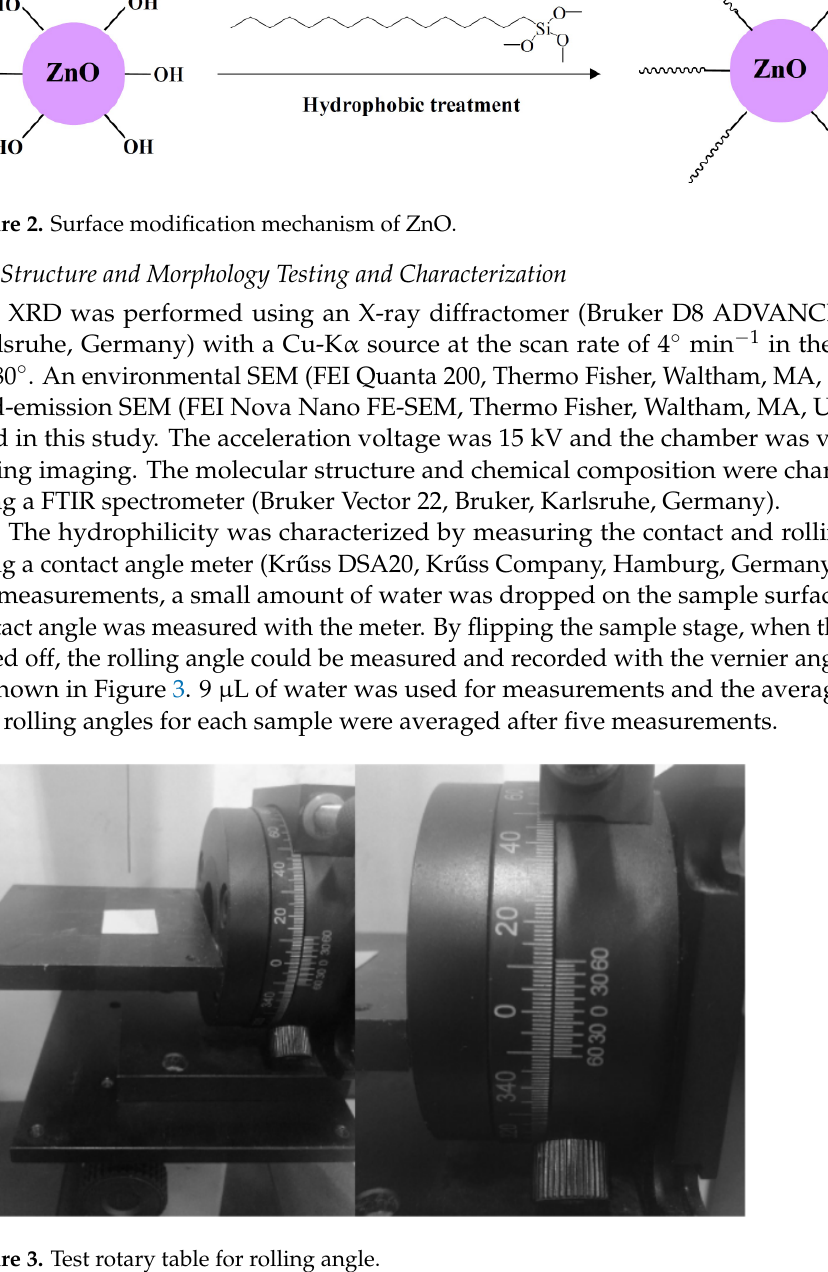
Figure 2. Surface modification mechanism of ZnO.